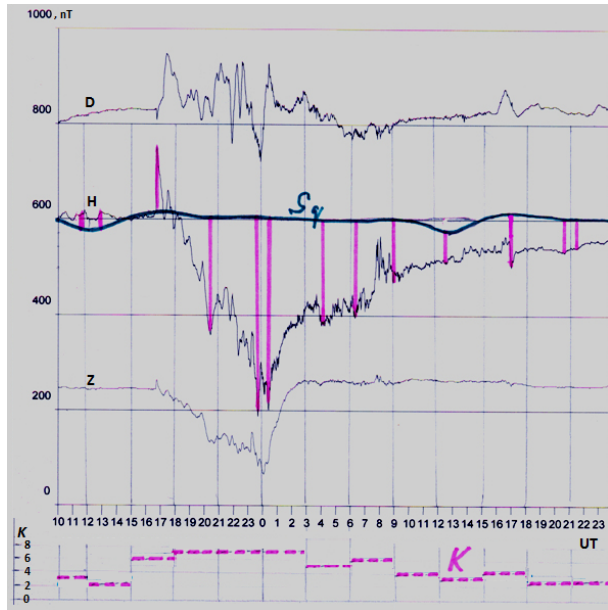
Figure 4. A schematic representation of the manual determination of geomagnetic variations’ amplitudes for K index calculation. Pur- ple vertical lines correspond to the maximum disturbances in the H component in 3h intervals. Similarly, the maximum disturbance amplitudes for the D component are determined. Then the values of the quiet daily variation Sq in each 3h interval are subtracted from the amplitudes. The largest value of the two amplitudes obtained for each of the 3h intervals using the observatory K index scale is converted into the K index value and adopted as the final